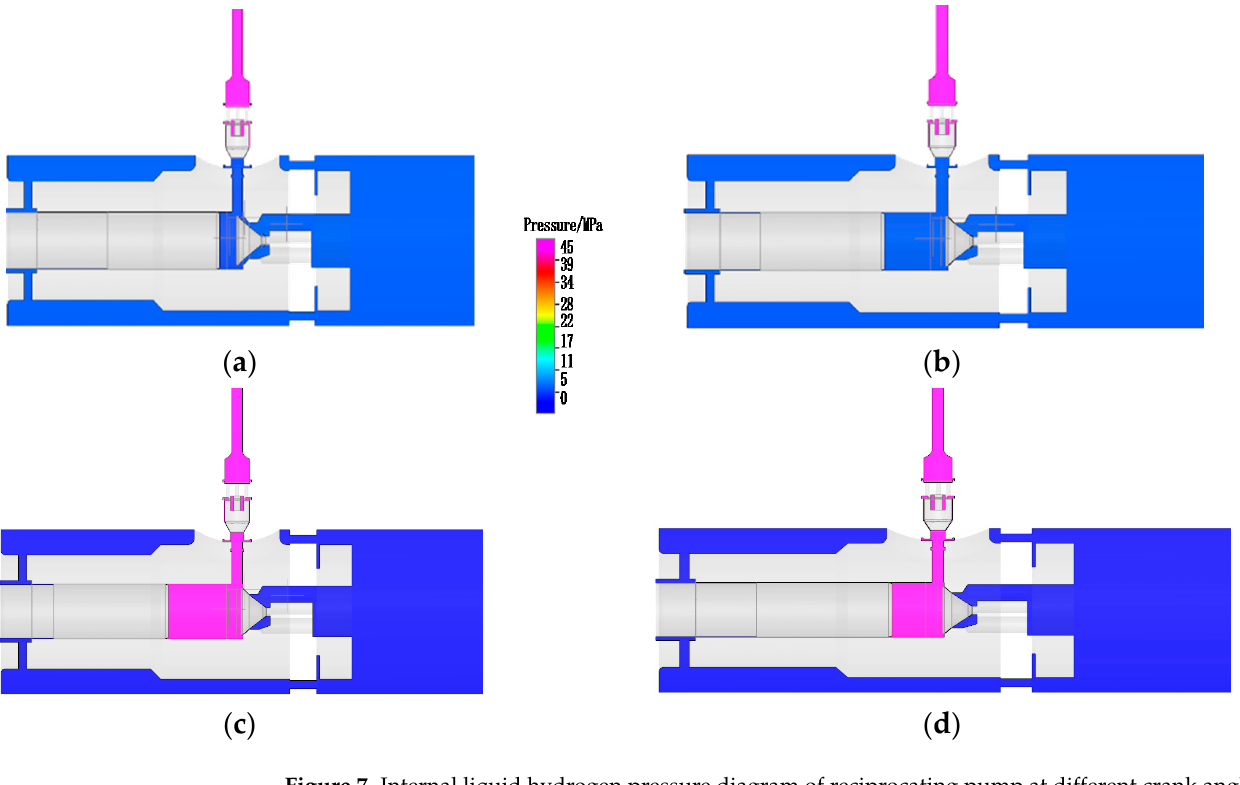
Figure 7. Internal liquid hydrogen pressure diagram of reciprocating pump at different crank